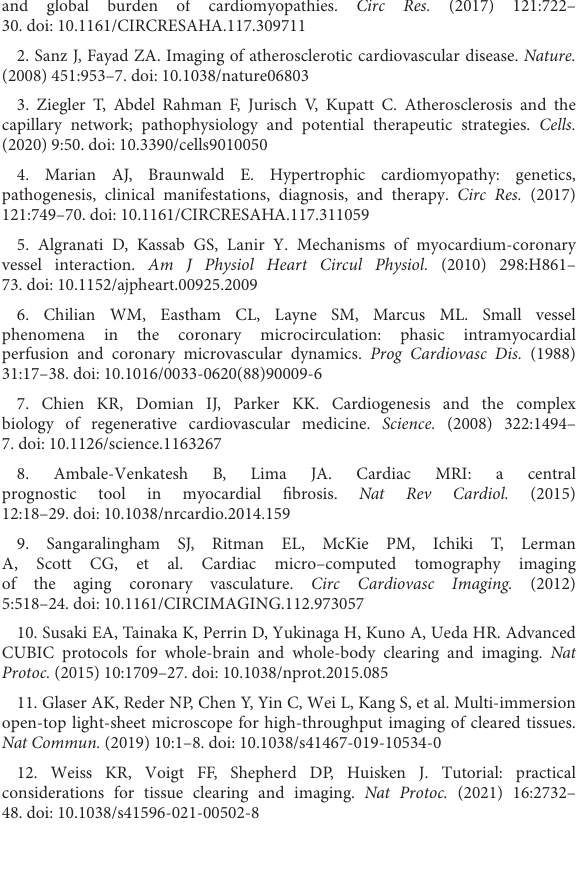
SUPPLEMENTARYVIDEO1 Rendered myocardial data shows the morphology and orientation of myocardial assembly.